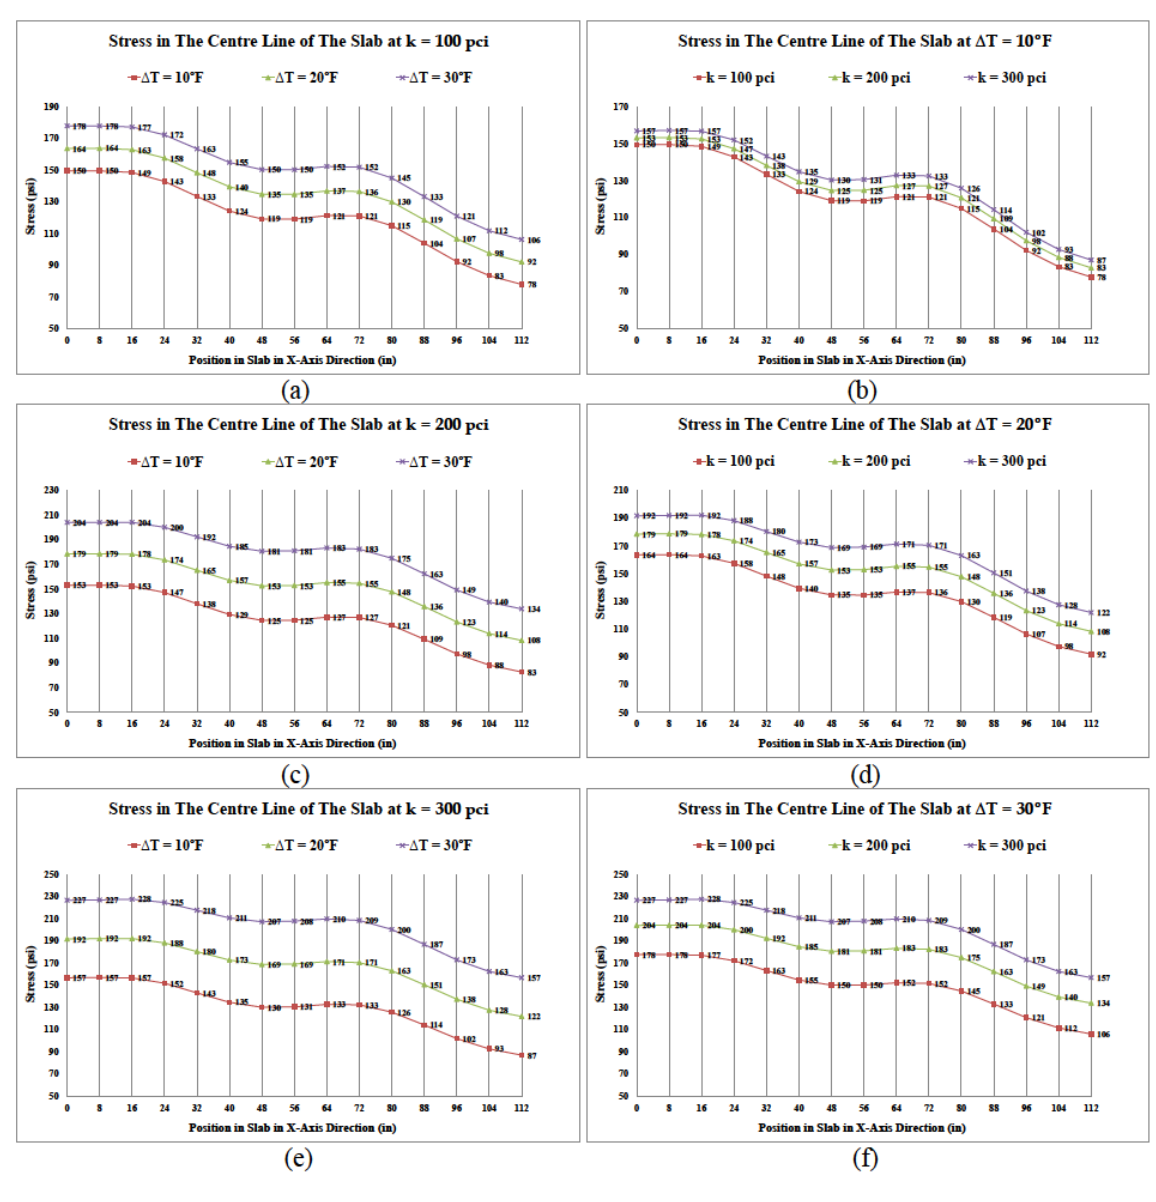
Figure 8: Stress in the center line of the slab